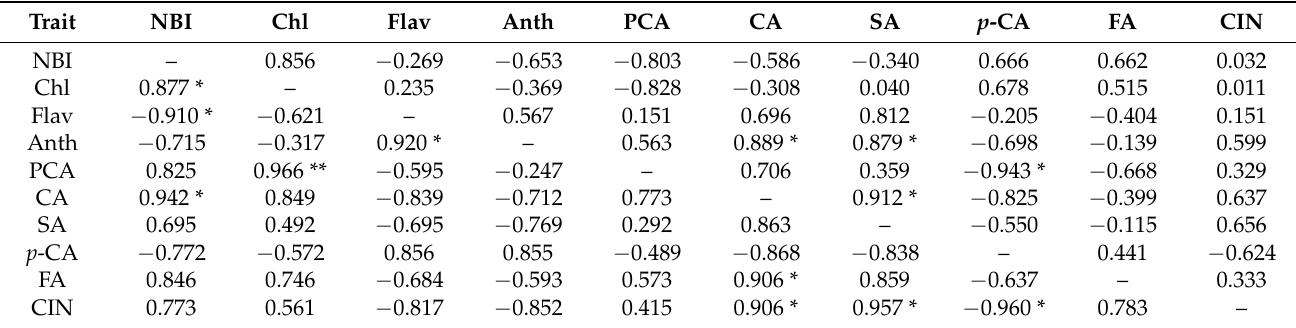
Table 4. Pearson correlation coefficients for correlations within and between metabolites observed under I 75 (above the diagonal) and I 0 (below the diagonal) irrigation treatments. NBI: nitrogen balance index; Chl: chlorophyll index;